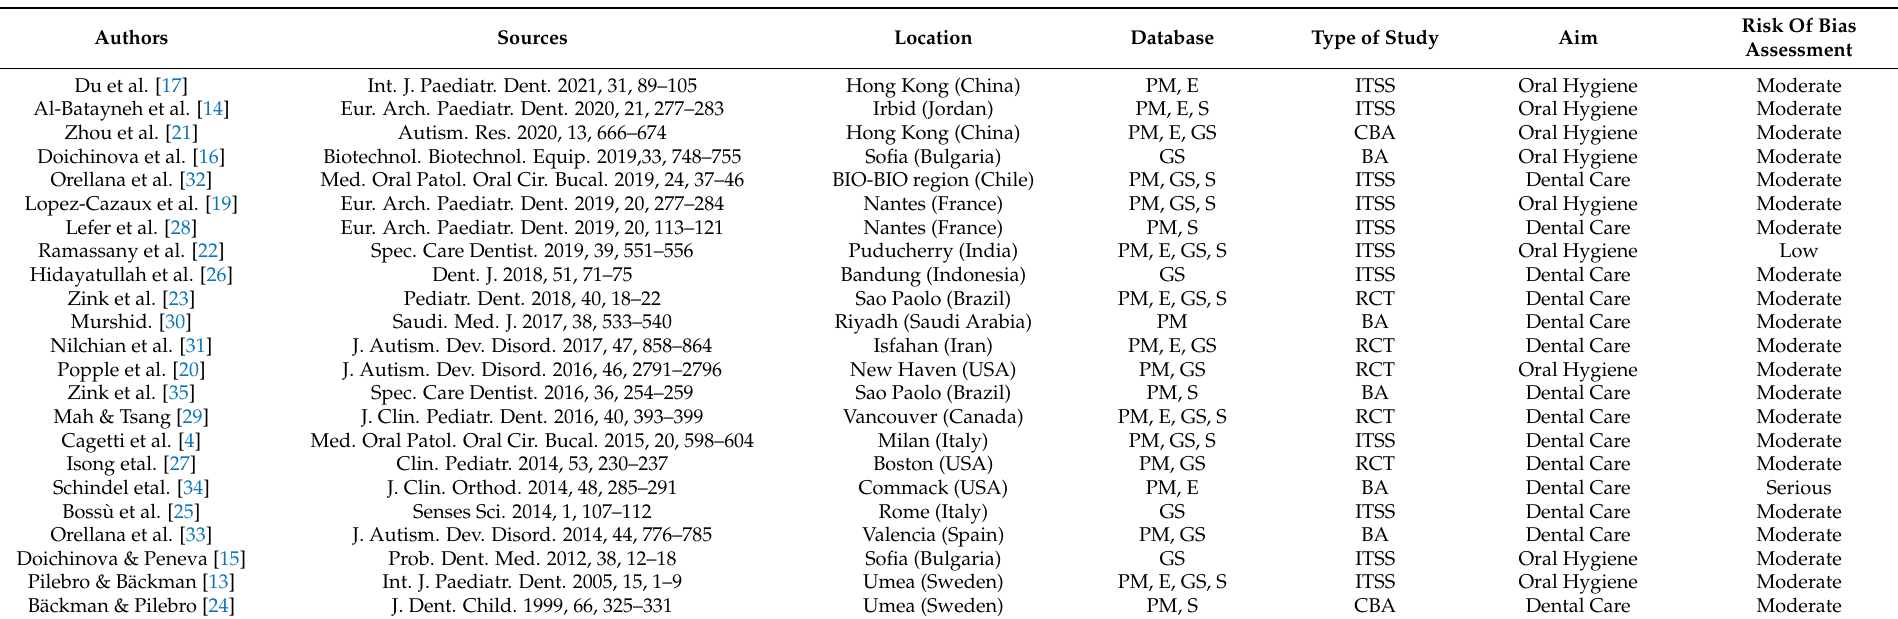
Table 1. General characteristics of the studies included regarding the use of visual tools in ASD children’s oral hygiene and dental